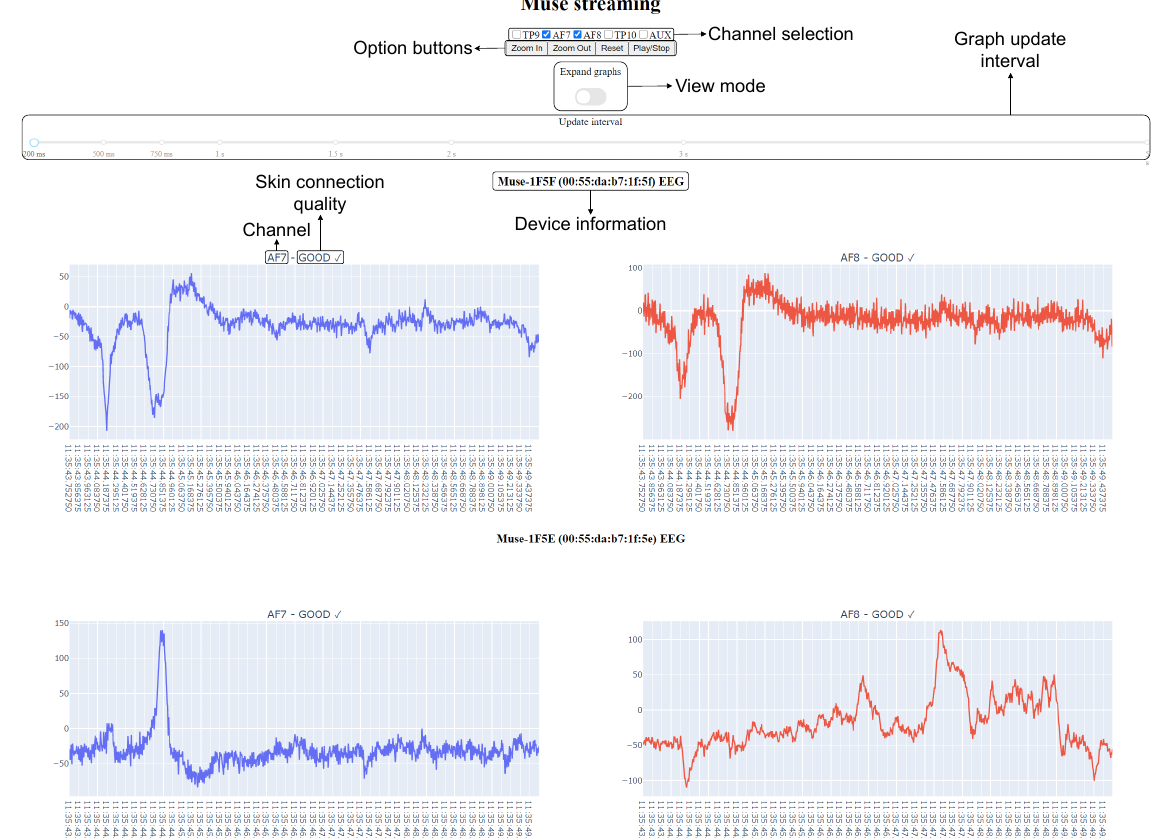
Figure 3. Overview of the interface.